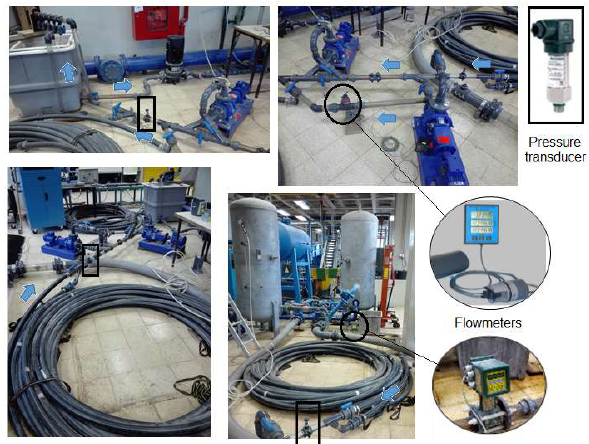
Figure 2. Experimental set-up at IST (DECivil-Lab).